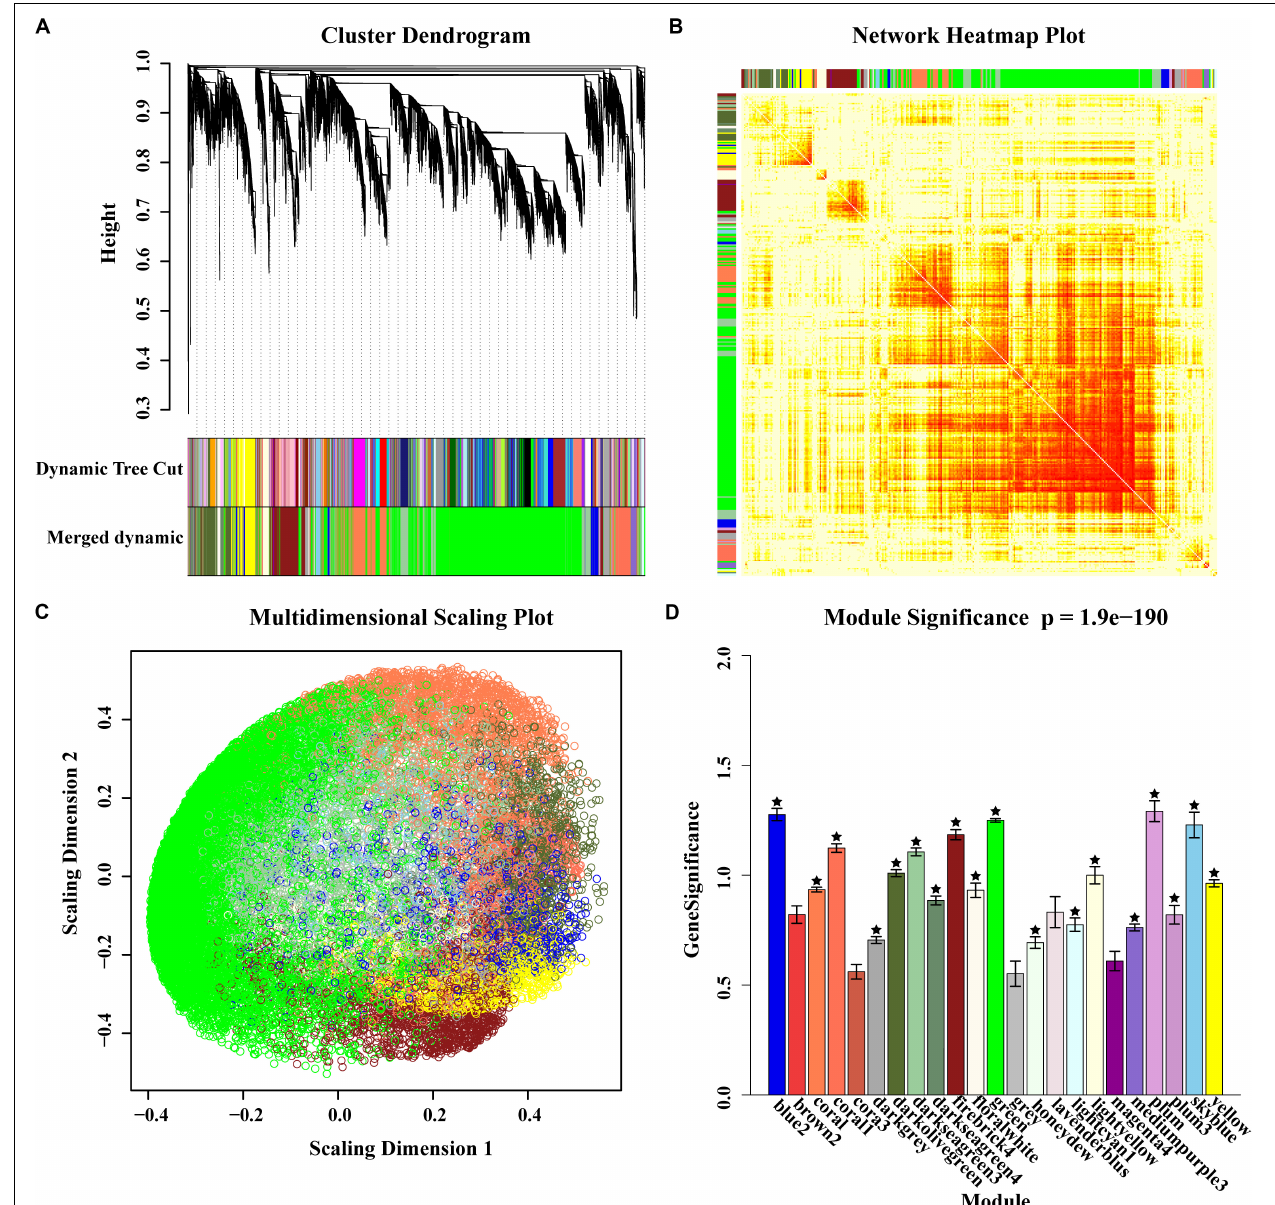
FIGURE 3 | Gene modules identified by weighted gene co-expression network analysis (WGCNA). (A) Gene dendrogram obtained by clustering the dissimilarity based on consensus Topological Overlap with the corresponding module colors indicated by the color row. Each colored row represents a color-coded module which contains a group of highly connected genes. A total of 23 modules were identified. (B) Heatmap plot of topological overlap in the gene network. In the heatmap, each row and column corresponds to a gene, light color denotes low topological overlap, and progressively darker red denotes higher topological overlap. Darker squares along the diagonal correspond to modules. The gene dendrogram and module assignment are shown along the left and top. (C) A multi-dimensional scaling plot of genes indicates that the green module is the most distinct. (D) Bar plot of mean gene significance across modules, and the star tagged module represents where the genes of selected regions are